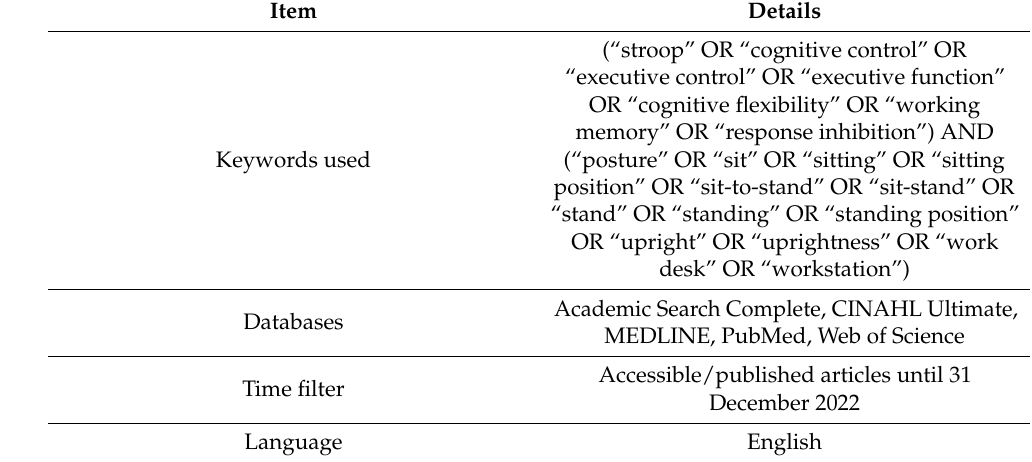
Table A1. Search strategy of the systematic review.